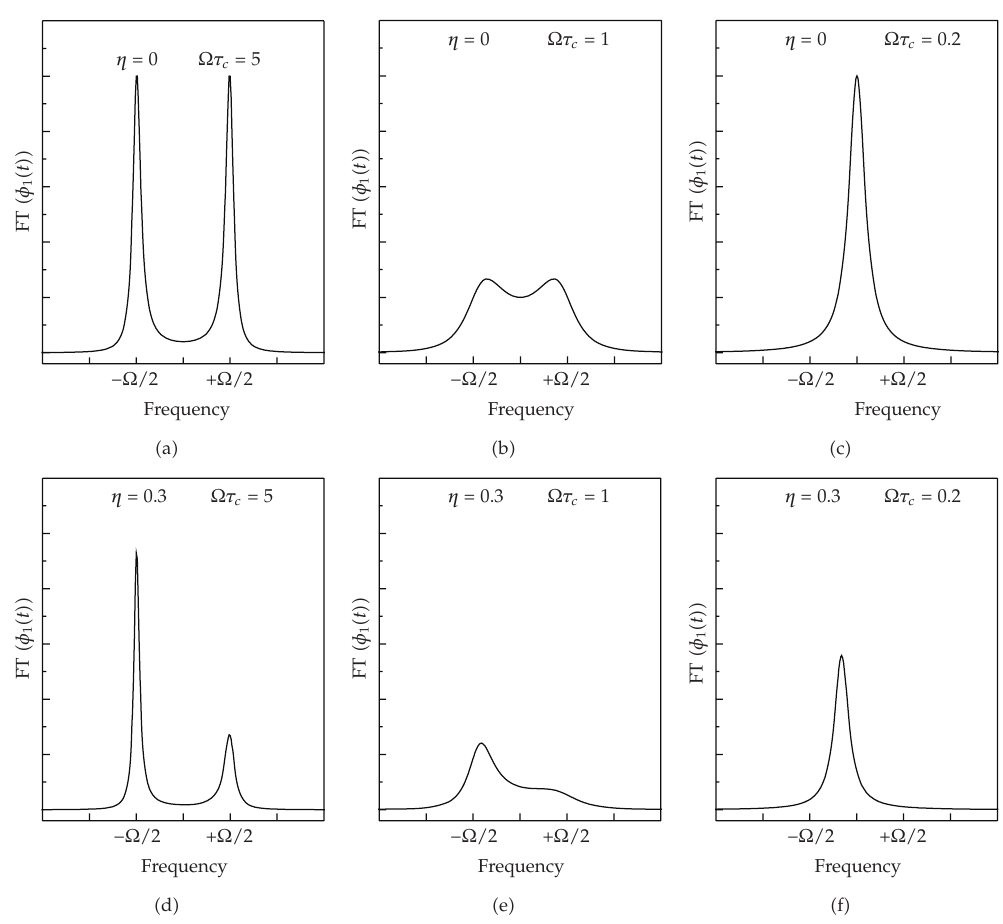
Figure 2: Optical spectrum in the presence of a single random telegraph: the Fourier transform of the relaxation function φ 1 (cid:5) t (cid:6) is plotted for symmetric (cid:5) η (cid:8) 0 (cid:6) and asymmetric (cid:5) η (cid:8) 0 . 3 (cid:6) jump processes for three di ff erent values of Ω τ c (cid:8) 5, 1, and 0.2.